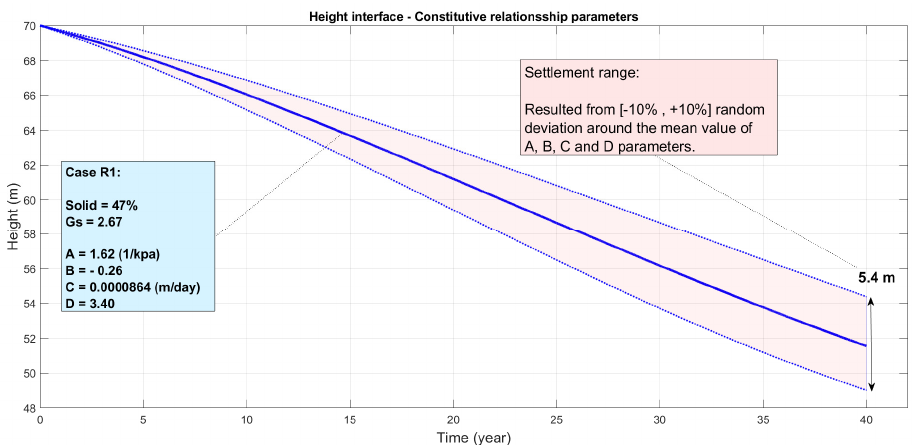
Figure 10. The sensitivity of settlement curves to constitutive relationship parameters.